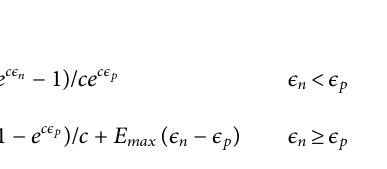
Frontiers in Materials |